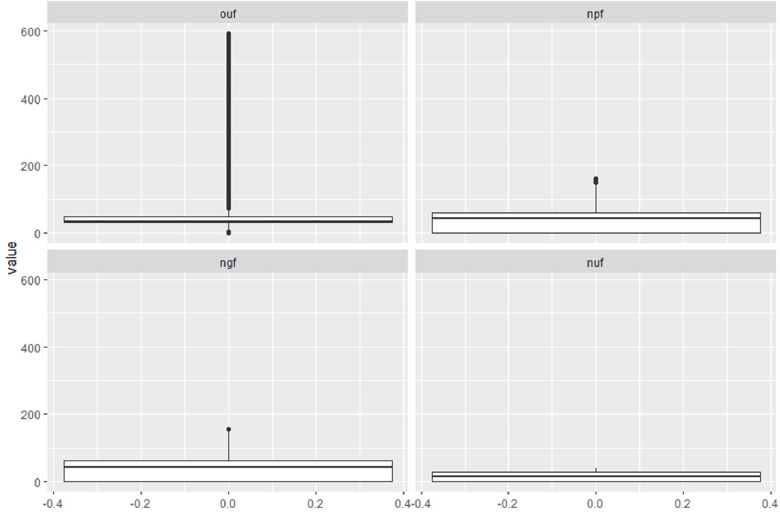
Figure 2. A box plot of the variability of the recorded parameters. Source: Own study.